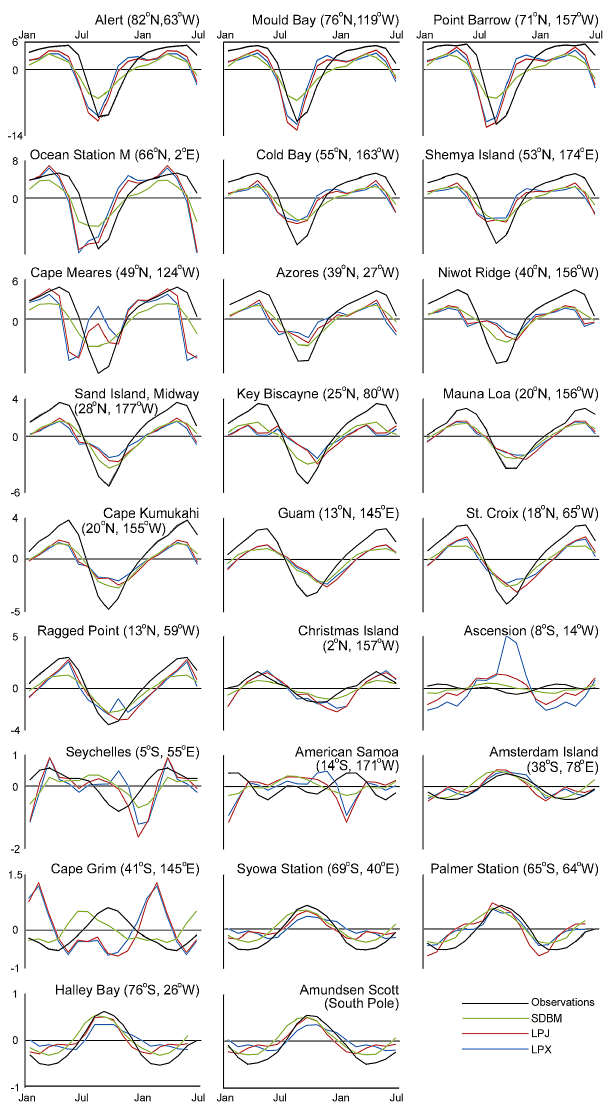
Fig. 3. Observed seasonal cycle of atmospheric CO 2 concentrations at 26 CO 2 stations over the period 1998–2005 (black line), taken from the CDIAC website (cdiac.ornl.gov) compared to the simu- lated seasonal cycle from the Simple Diagnostic Biosphere Model (SDBM) (green line); LPJ (red); and LPX (blue). The y-axis indi- cates variation in atmospheric CO 2 concentration about the mean. The x-axis is months from January through 18 months to